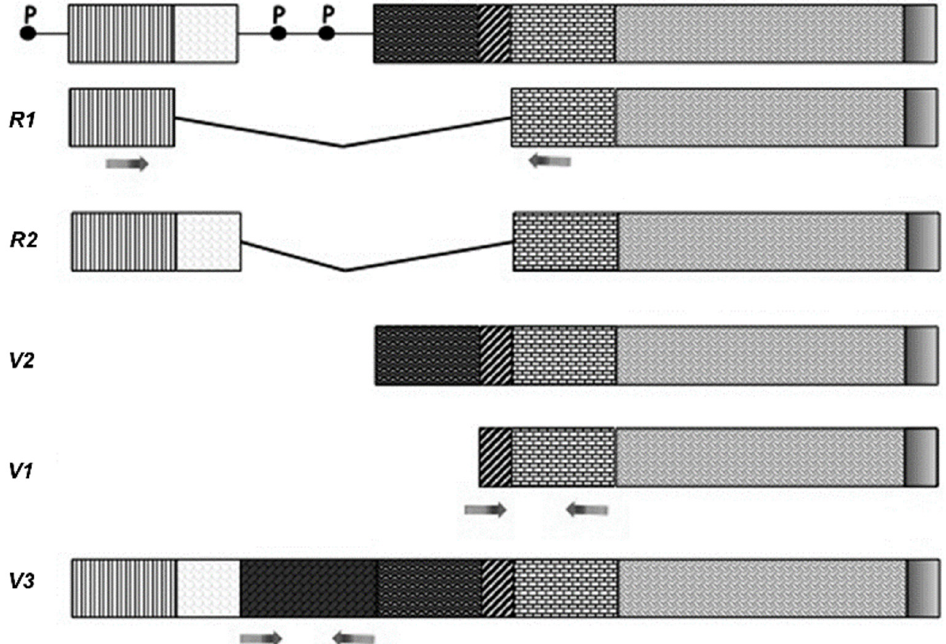
Figure 1. Schematic representation of the VAChT gene and different rat splice variants. P indicates the different putative promoter sites. The arrows indicate the sites where the primers were designed.